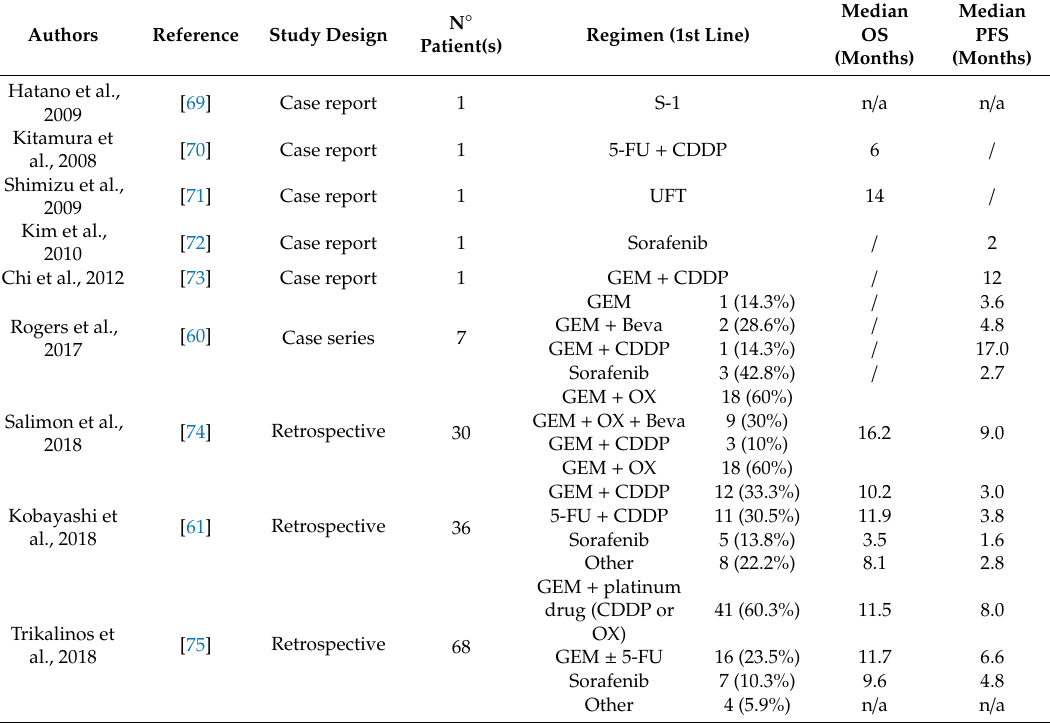
Table 3. Literature review of systemic chemotherapy regimens in the first-line